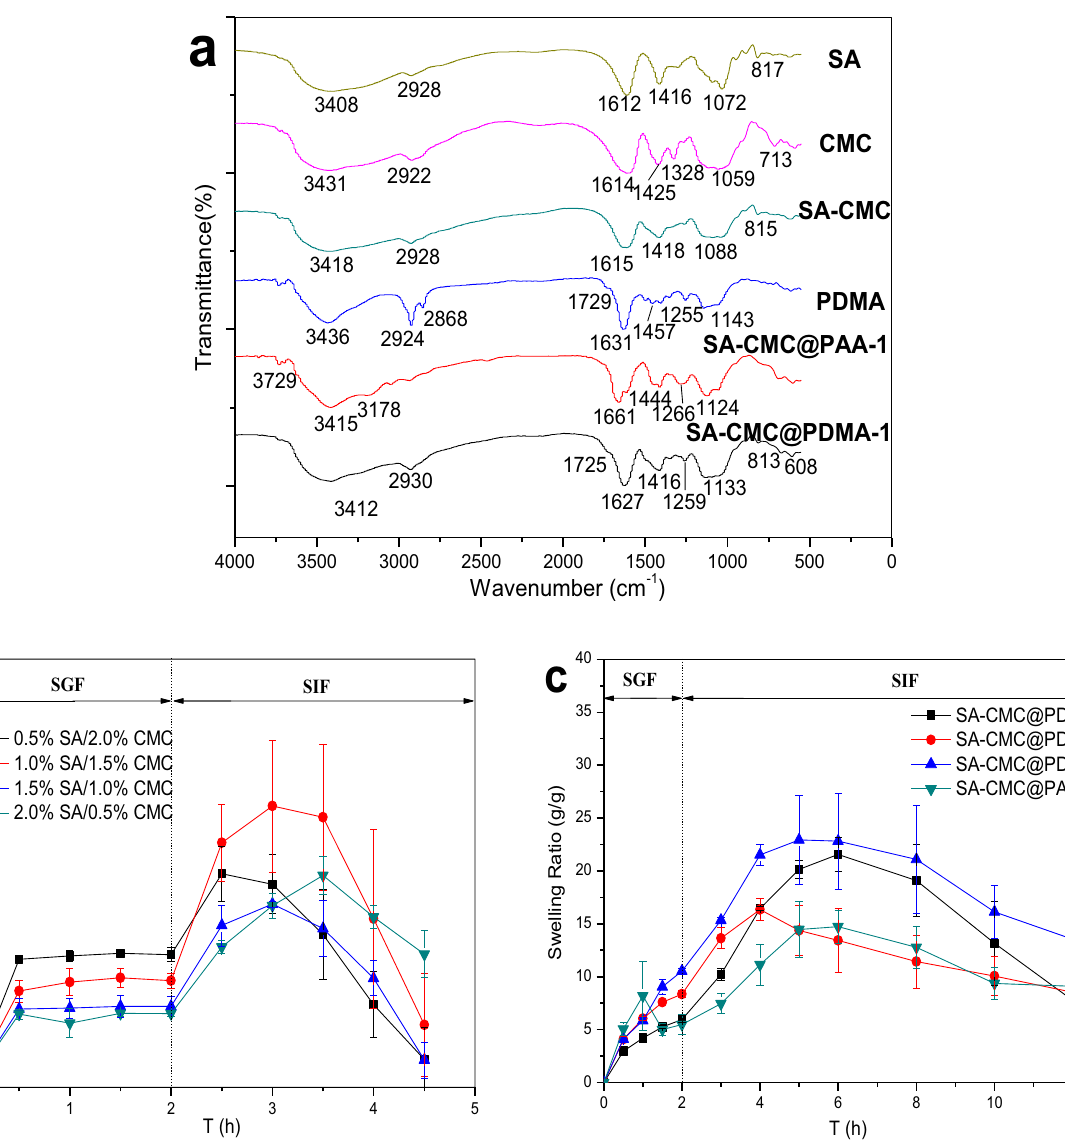
Figure 6. FTIR spectrum of SA, CMC, SA-CMC hydrogel, PDMA hydrogel, SA-CMC@PAA-1 and SA-CMC@ PDMA-1 double layer hydrogel ( a ). Swelling profiles of hydrogels in simulated gastrointestinal fluid: ( b ) Single layer hydrogel with different inner layer composition; ( c ) SA-CMC@PDMA-1, 2, 3 hydrogel and SA-CMC@ PAA-1).